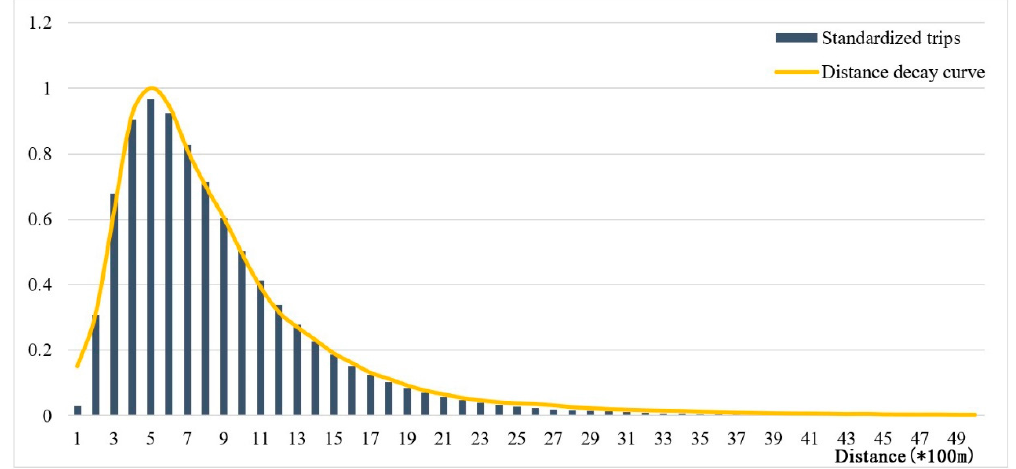
Figure 3. Distribution of cycling trips and fitting curve by trip distance.